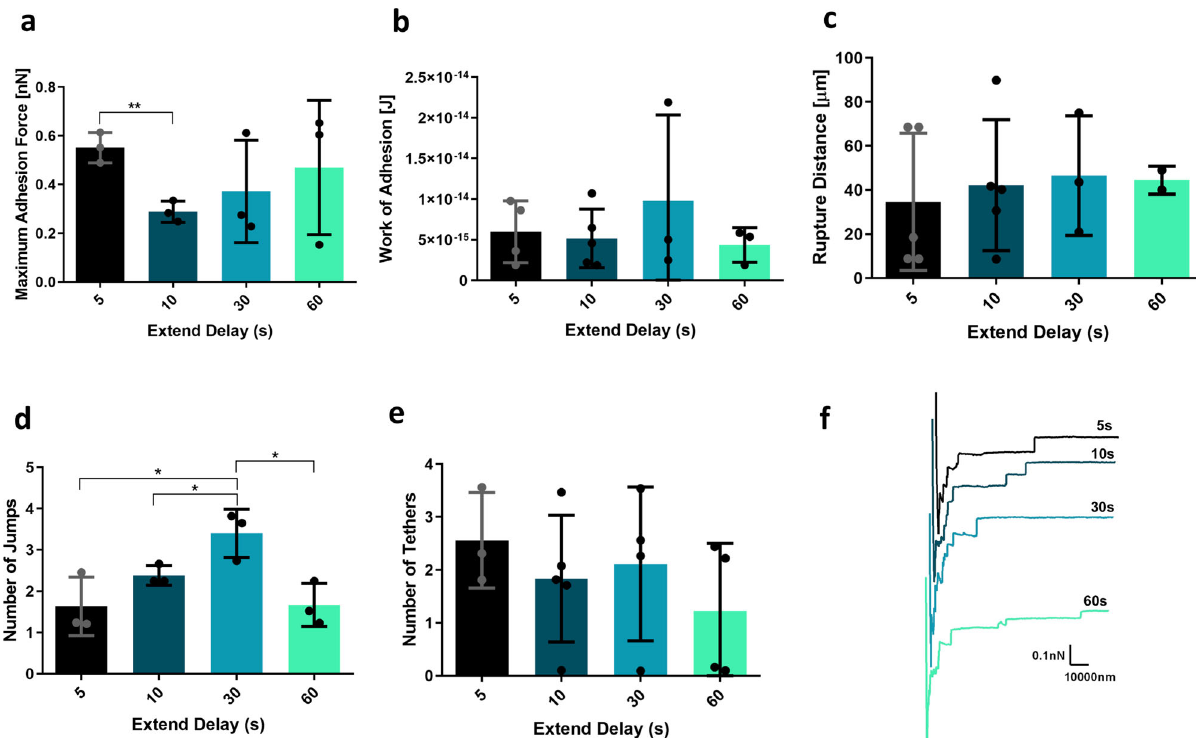
Fig. 3 Interaction of C. glabrata wild-type strain KUE100 with human vaginal epithelial VK2/E6E7 cells by SCFS, using different contact times: 5, 10, 30, and 60 s. Characterization of these interactions is based on the: a maximal adhesion force, b work of adhesion, c rupture distance, d number of jumps, and e number of tethers measured on each retraction curve. f Representative force – distance curves are presented for each contact time (the lighter the force curve, the higher the contact time). Horizontal lines indicate the average levels from at least 4 yeast cells, from at least 3 independent cell cultures, immobilized on the cantilever for the interaction with epithelial cells and 64 or 16 force – distance curves were recorded, for 5 and 10 s, and 30 and 60 s, respectively. Error bars indicate SDs. * P < 0.05; ** P < 0.01, n ≥ 3, except for the 60 s value in c ( n =